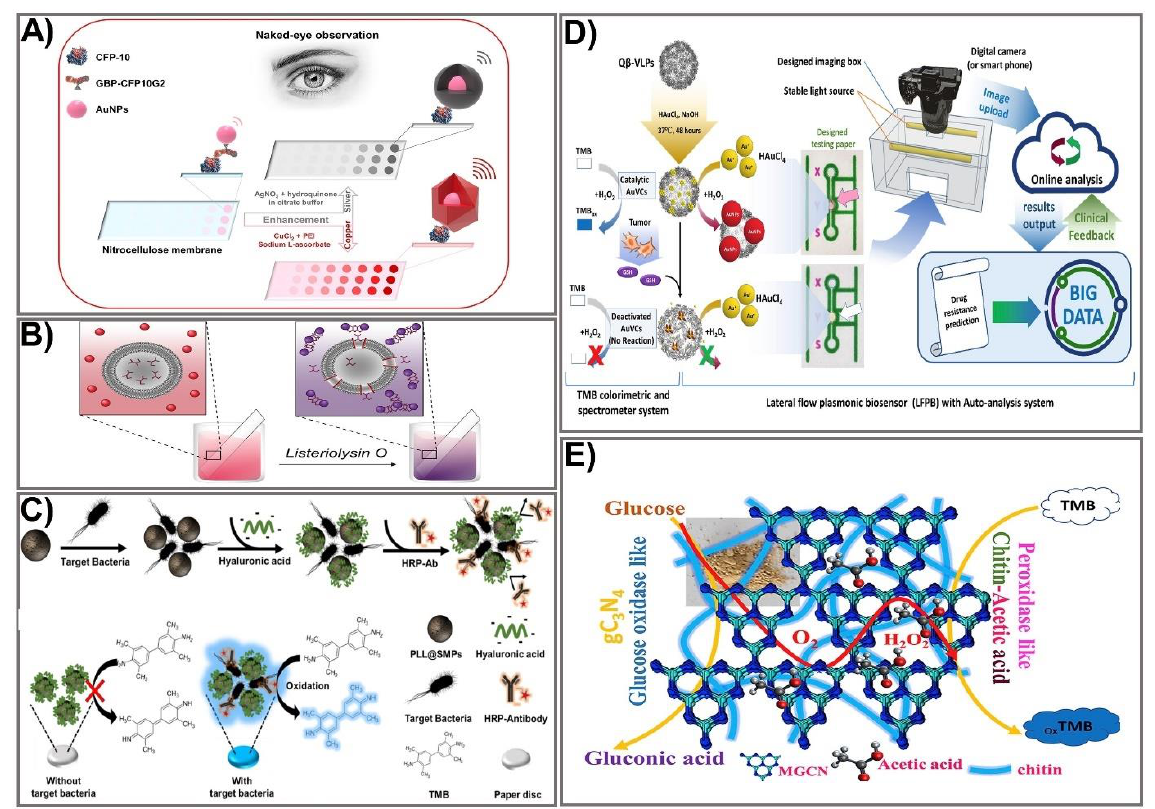
Figure 2. Strategies for signal amplification in colorimetric PADs. ( A ) A representation of naked-eye detection of CFP-10 using a copper/silver nanoshell enhancement-based dot-blot immunoassay platform. Adapted with permission from Ref. [48] . ( B ) The mechanism for detection of pore-forming toxin Listeriolysin O (LLO) using AuNP aggregation-based signal enhancement. Adapted with permission from Ref. [49] . ( C ) The design process and mechanism for detection of Escherichia coli O157:H7 bacteria using an enzyme functionalization-based signal enhancement strategy. Adapted with permission from Ref. [50] . ( D ) The principle of fabrication and detection of glutathione using peroxidase-like AuNP-based signal amplification. Adapted with permission from Ref. [51] . ( E ) The fabrication and detection procedure using a polymer- functionalized, metal-free dual enzyme-mimicking system to detect peroxide glucose. Adapted with permission from Ref. [37] .